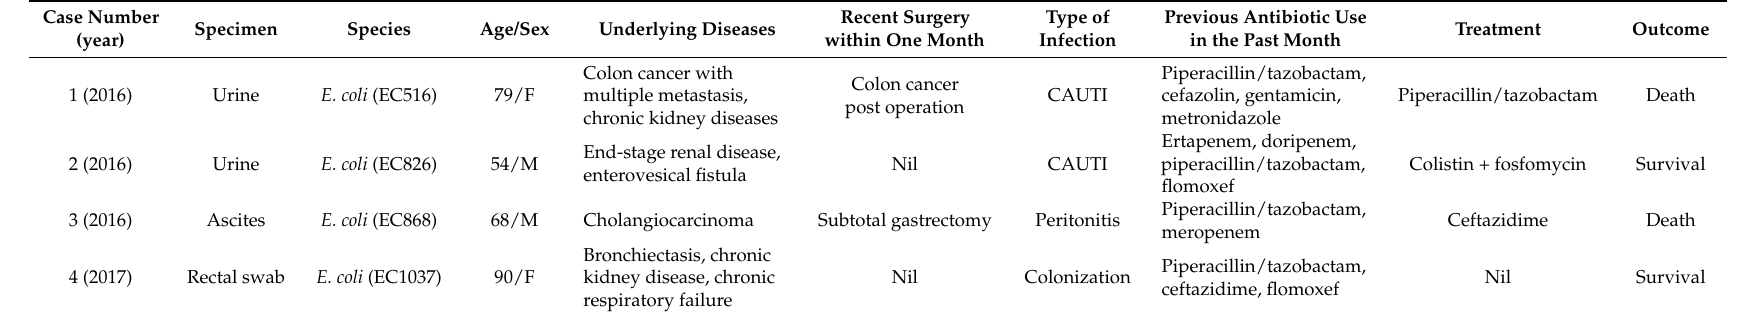
Figure 1. Pulsed-field gel electrophoresis (PFGE) patterns of four mcr-1 -positive carbapenem-resistant Escherichia coli ( E. coli ). Table 1. Clinical significance of mcr-1 -positive carbapenem-resistant E. coli isolates.